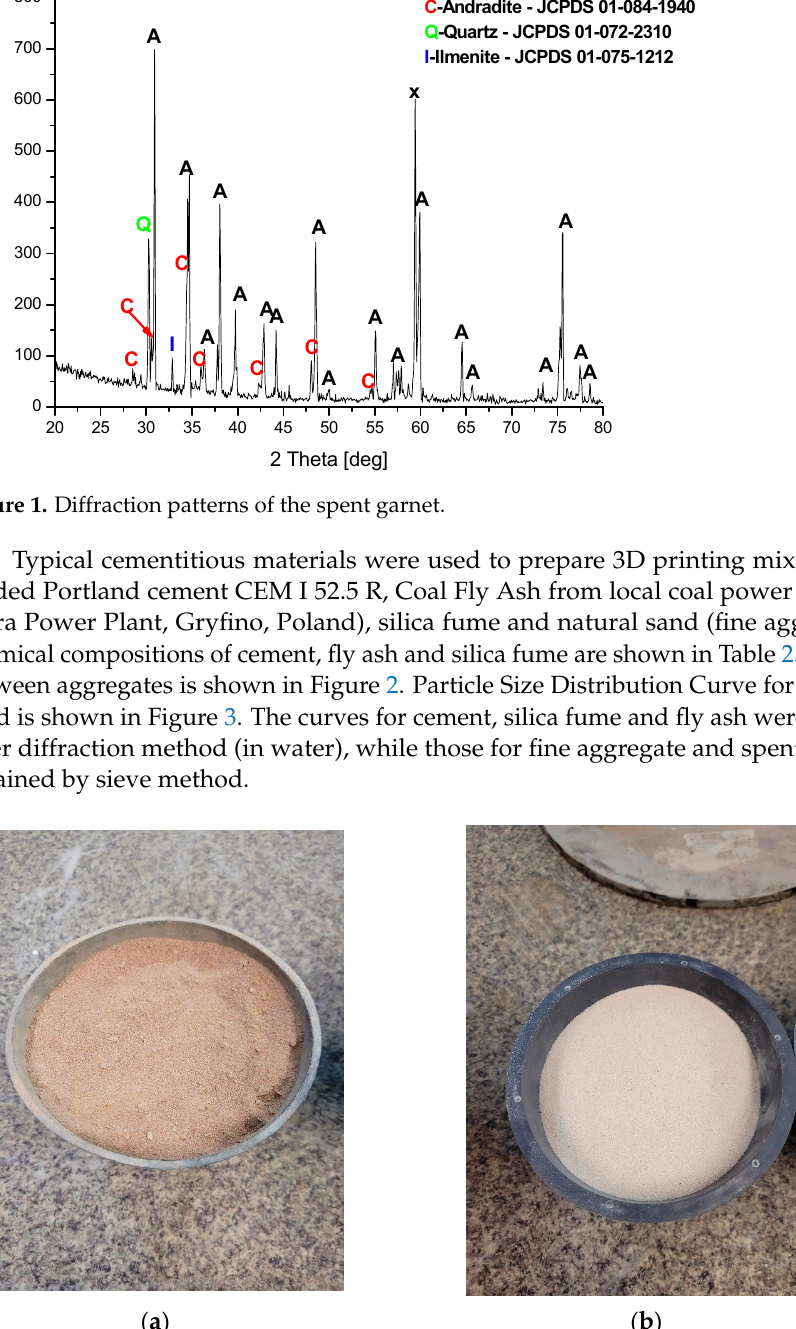
Table 1. Metals’ leaching concentrations from the spent garnet.